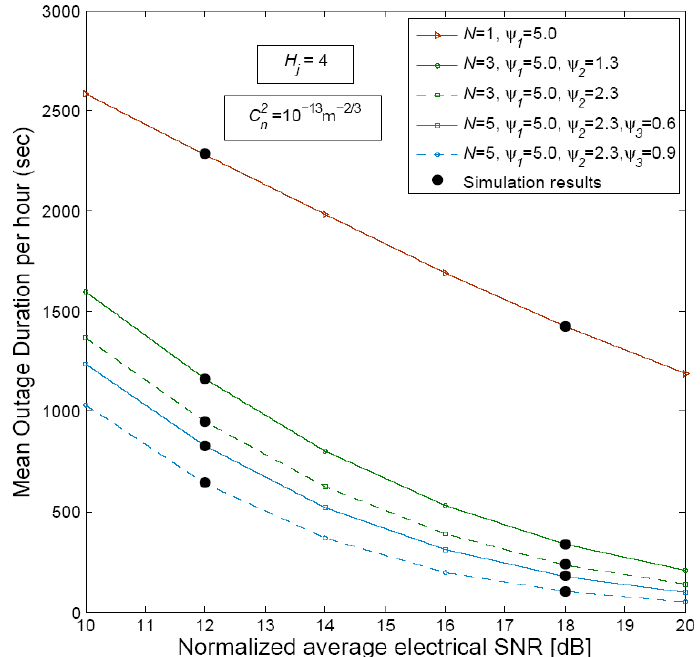
Figure 6. Total mean outage duration (MOD) of a quadruple-hop relay-aided system with varying path configurations as a function of a wide range of γ / μ , for negative exponential (NE) modeled saturated turbulent channels along with different amounts of pointing mismatch.